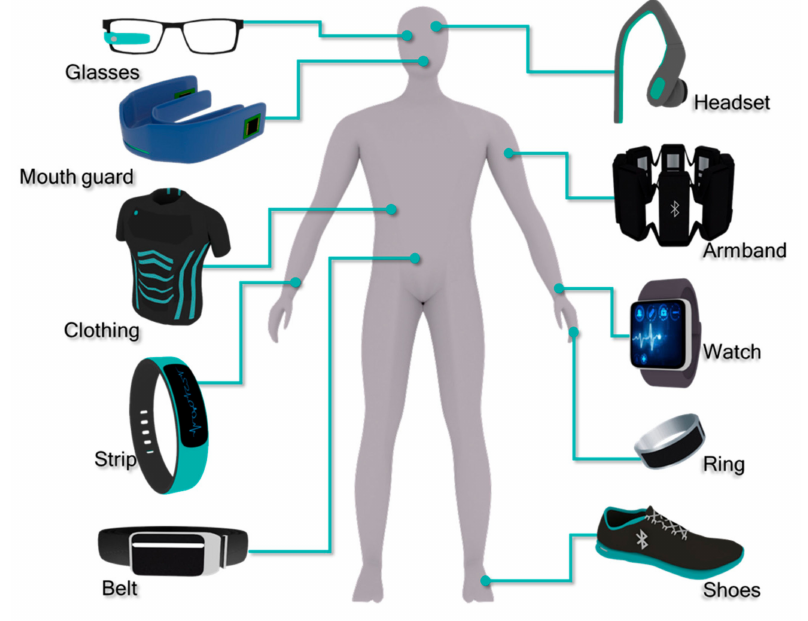
Figure 2. Portable medical and healthcare devices worn on body